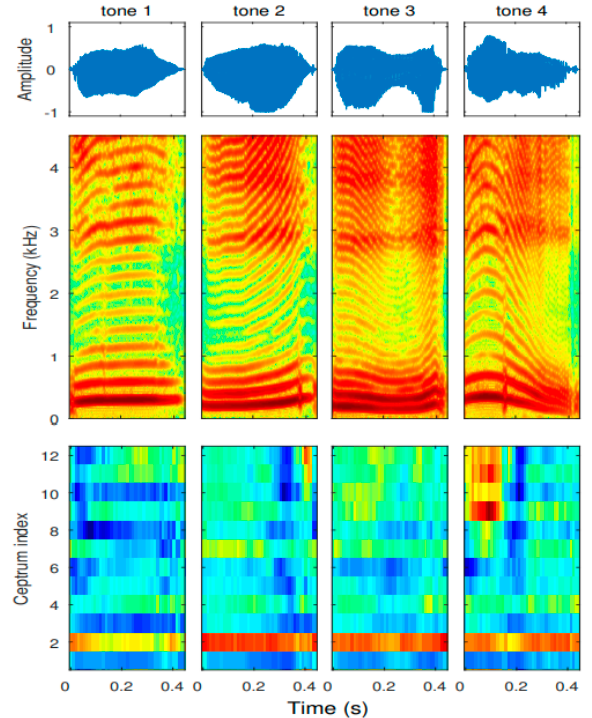
Figure 4. Machine learning data from previous studies on tone recognition [34]. Top: Time waveforms; Middle: Spectrograms; Bottom: Mel-frequency cepstral coefficients (MFCCs).